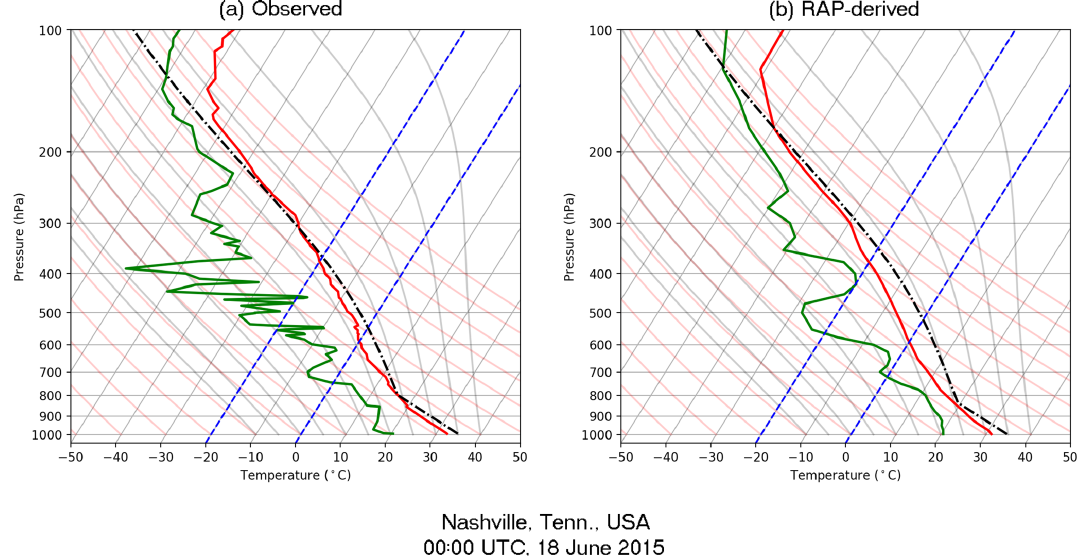
Figure 3. Comparison of observed (a) vs. RAP-derived (b) soundings for a case when the MLCAPE discrepancy exceeded 1000Jkg − 1 (observed: 1028Jkg − 1 ; RAP: 2051Jkg − 1 ). Minor mischaracterizations of low-level moisture contributed to a large response in MLCAPE during the vertical integration of the parcel